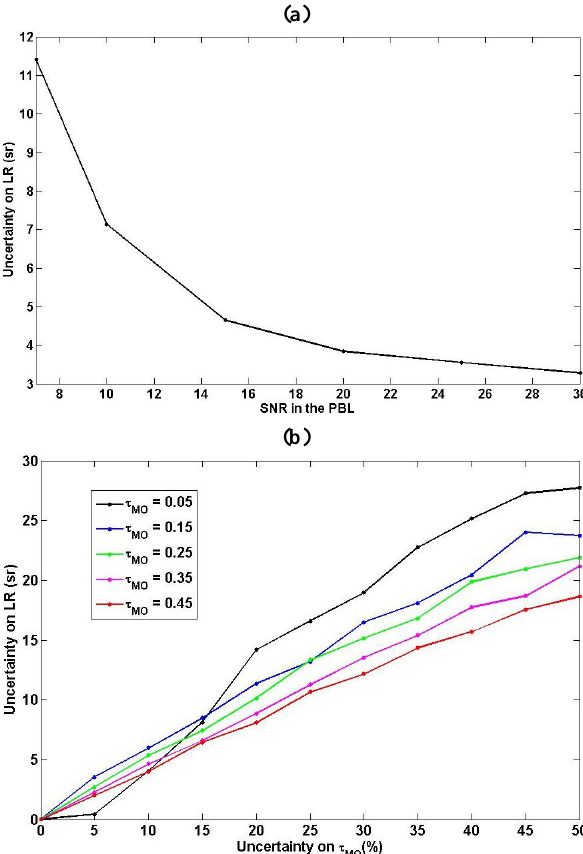
Fig. 7: Results of Monte Carlo simulations to assess the uncertainty on LR retrieval (a) due to the SNR in the PBL of the lidar range-corrected signal and (b) due to the uncertainty on MODIS-derived AOD ( σ MO ) for mean AOD values ( τ MO ) of 0.05, 0.15, 0.25, 0.35, 0.45.